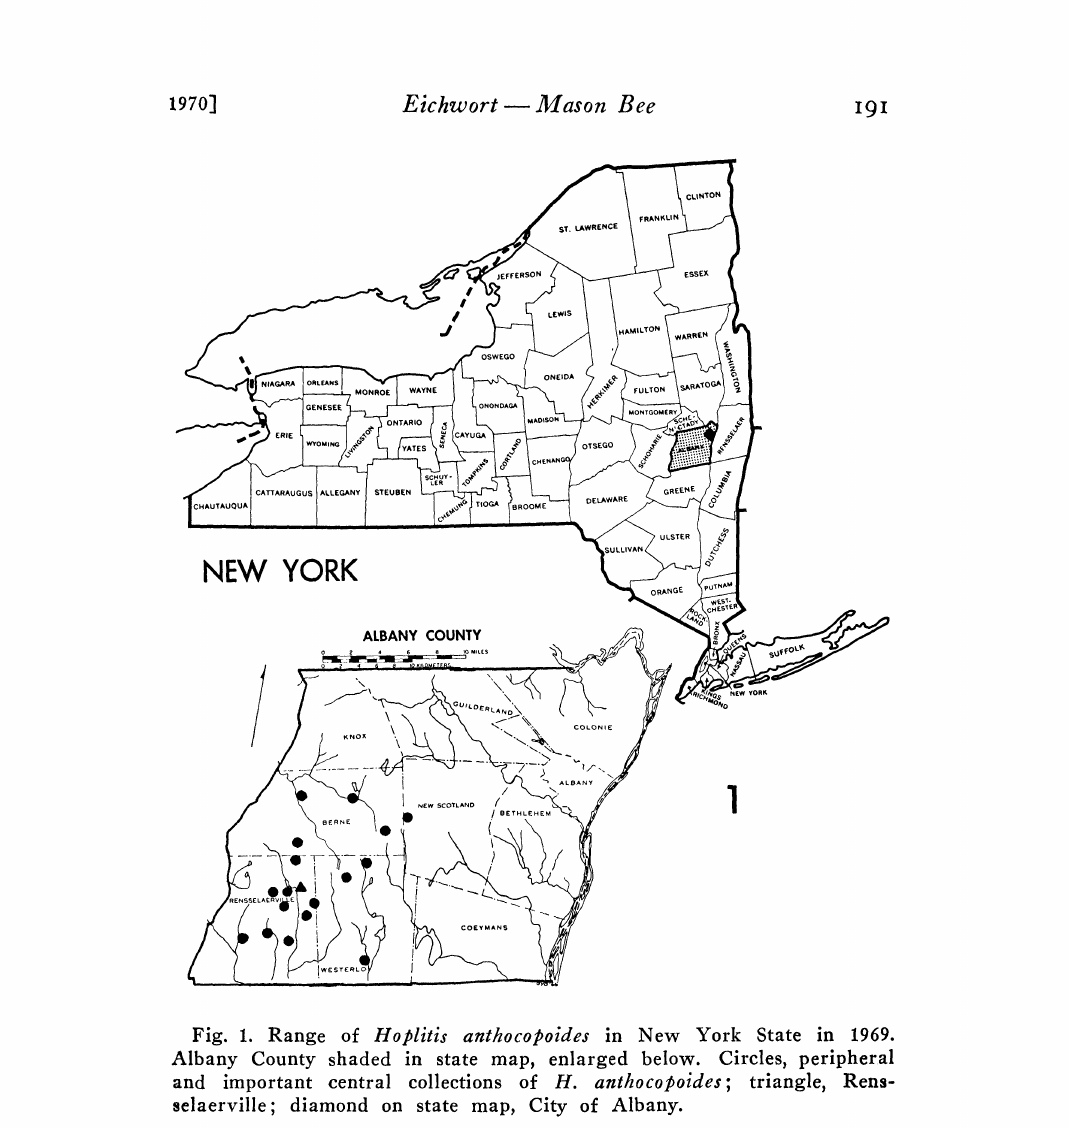
Fig. 1. Range of Hoplitis anthocopoides in New York State in 1969. Albany County shaded in state map, enlarged below. Circles, peripheral and important central collections of H. anthocopoides; triangle, Rens- selaerville; diamond on state map, City of